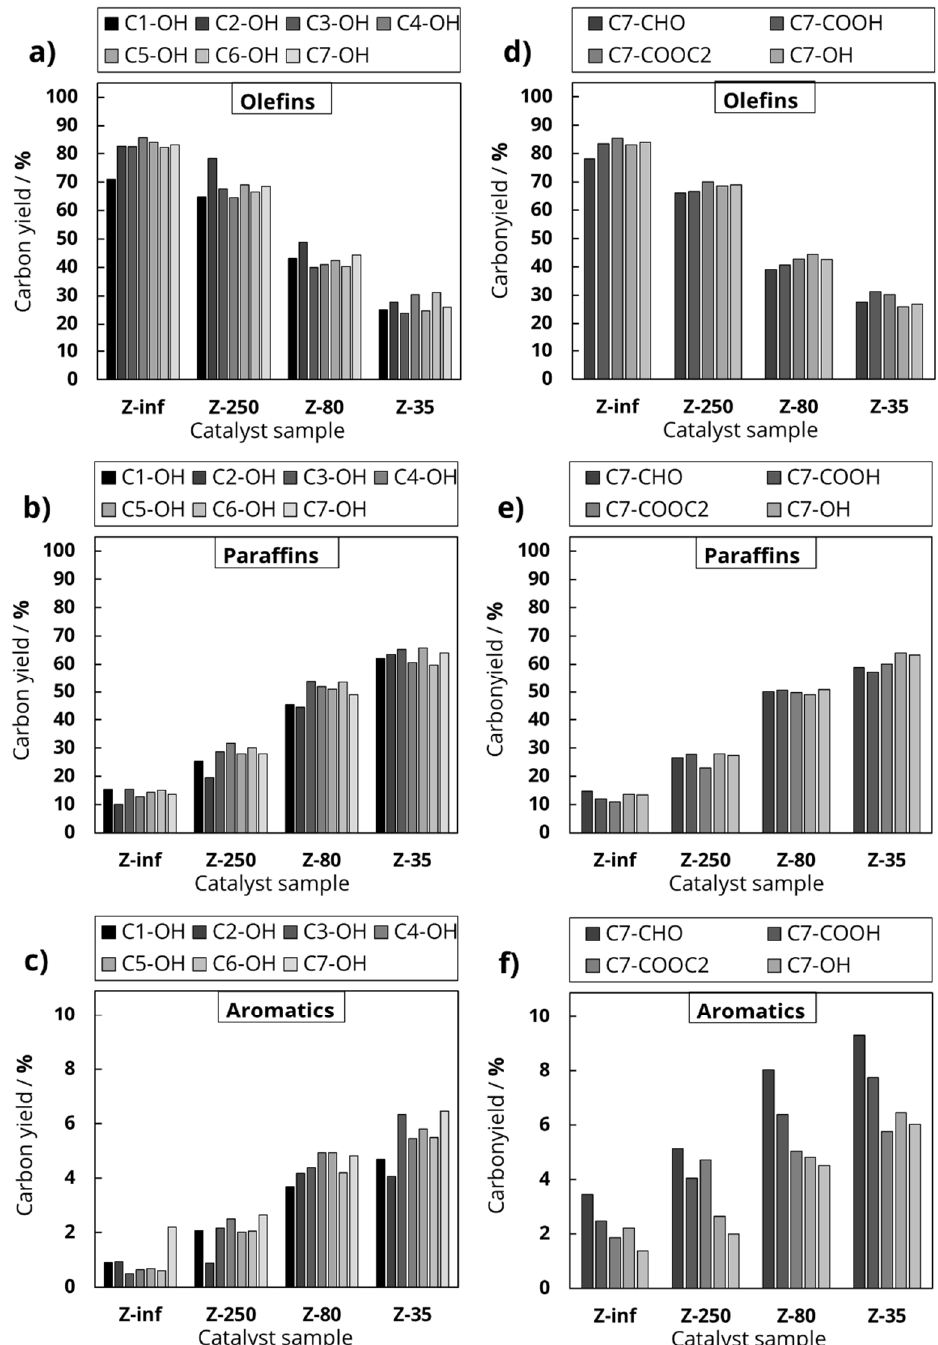
Figure 7. Comparison of catalytic results of prepared H ‐ ZSM ‐ 5 zeolite samples with various Si/Al ratios at the conversion of different feeds based on substance group: ( a – c ) comparison of carbon yields in alcohol conversion in experimental series 1 and ( d – f ) comparison of oxygenates with different functional groups in experimental series 2.